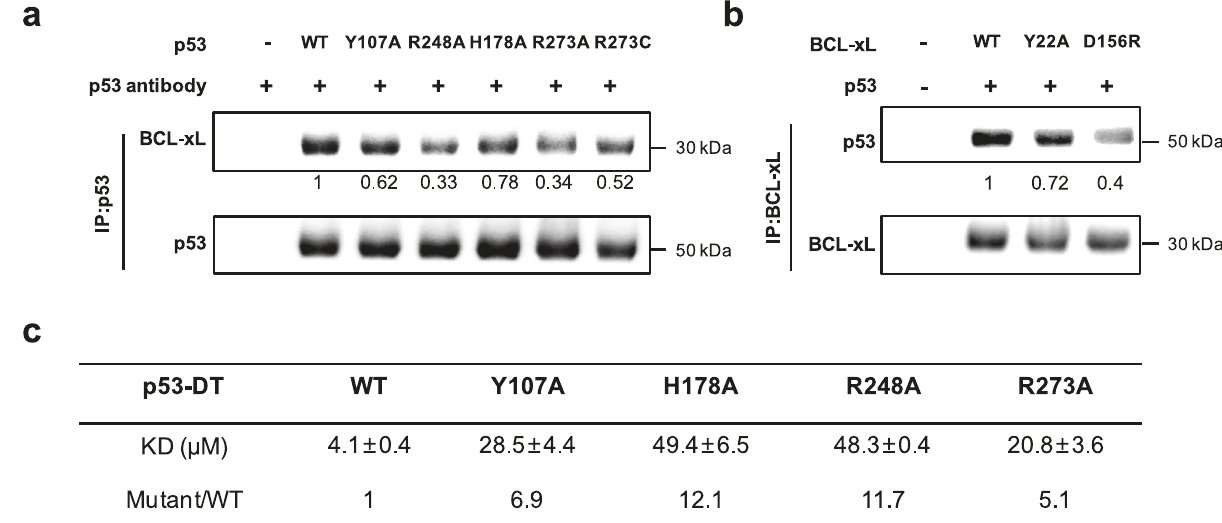
Fig. 4 Mutations of interaction residues of p53 and BCL-xL disrupt their interaction. a Wild-type or mutant p53 plasmid was transiently transfected into p53-null H1299 cells. Cell lysates were immunoprecipitated using anti-p53 antibody, and subjected to western blotting as indicated. b Wild-type or mutant BCL-xL plasmid ( fl ag-tagged) was co-transfected with wild-type p53 plasmid into H1299 cells. Cell lysates were immunoprecipitated using anti- fl ag antibody, and subjected to western blotting as indicated. The results of three independent replicates were similar, with one representative experiment being shown. Semi-quantitation using band densitometry was performed and the relative binding compared to wild type was show below. c ITC assay demonstrated af fi nity of wild-type or mutant p53-DT to BCL-xL. The KD values indicate average of three independent titrations ± SEM. The relative binding af fi nity (Mutant/WT) is indicated. Source data are provided as a Source Data fi Interfacial mutants inhibit p53-mediated apoptosis . The inhi- by Annexin V/PI staining and fl ow cytometry assay. The data bition of anti-apoptotic BCL-xL is a signi fi cant part of p53- showed that the transfection of wild-type p53 induced approxi- mediated apoptosis. We then tested the effect of the designed p53 mately 26.7% of apoptotic cells, whereas H178A, R248A and mutants on p53-mediated apoptosis. P53-null H1299 cells were R273A mutants led to about 9.4%, 8.9% and 12% of apoptotic transfected with wild-type or mutant p53 for 48 hours, followed cells, respectively (Fig. 5a, b, Supplementary Fig. 13). In addition,